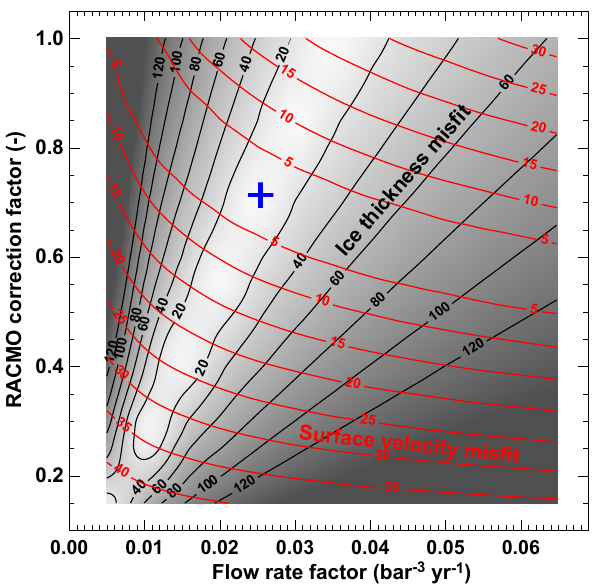
Figure 3. Averaged absolute misfit with OIB thickness data in m (black contours and grey shading) and ice flow velocity in myr − 1 (red contours) for different combinations of f RACMO and A f (see Eqs. 1 and 2). The optimal parameter combination is indicated by the blue